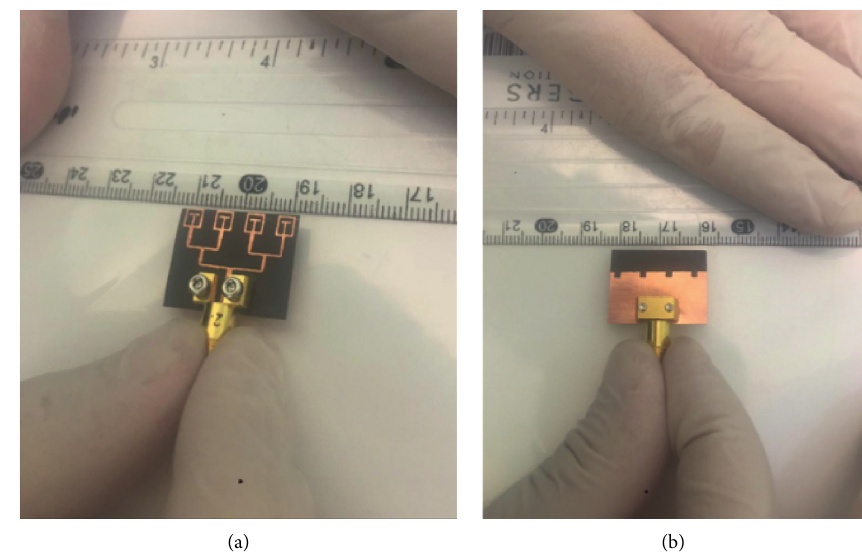
Figure 7: Fabricated antenna array prototype: (a) front view; (b) back view.